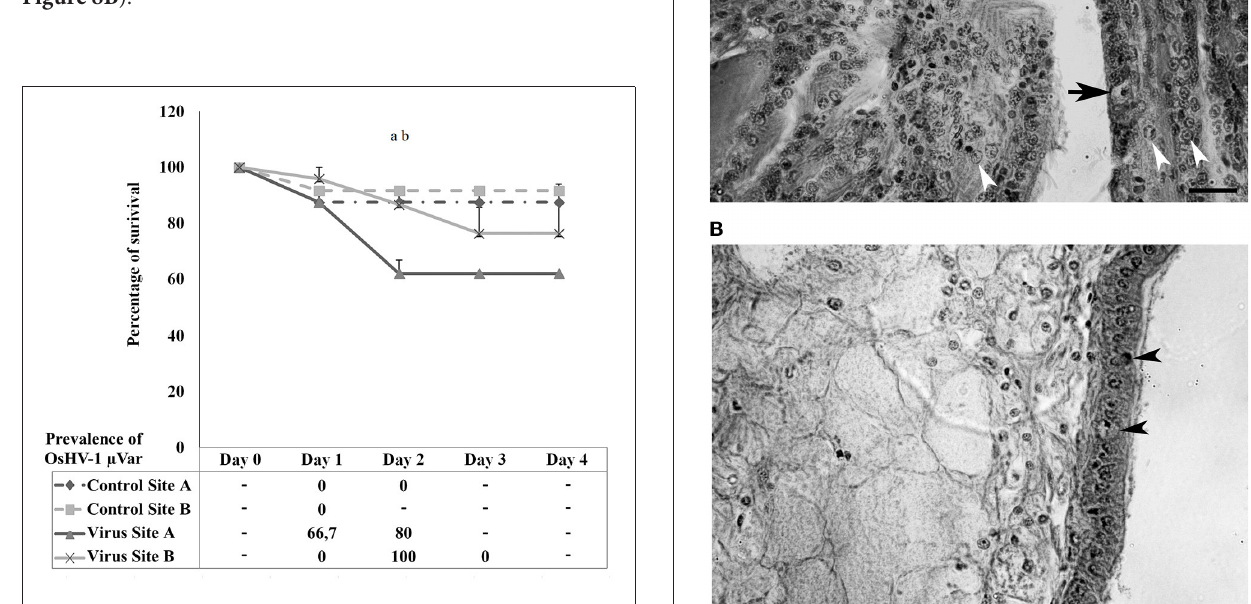
FIGURE 8 | Histological section of a heavily infected oyster. (A) Gill tissue. Enlarged cells are indicated with arrows and chromatic margination is indicated with arrowheads. (B) Mantle tissue. Epithelial cells showing abnormal nucleus are indicated with arrowheads. (Scale bars, 20 µ m).